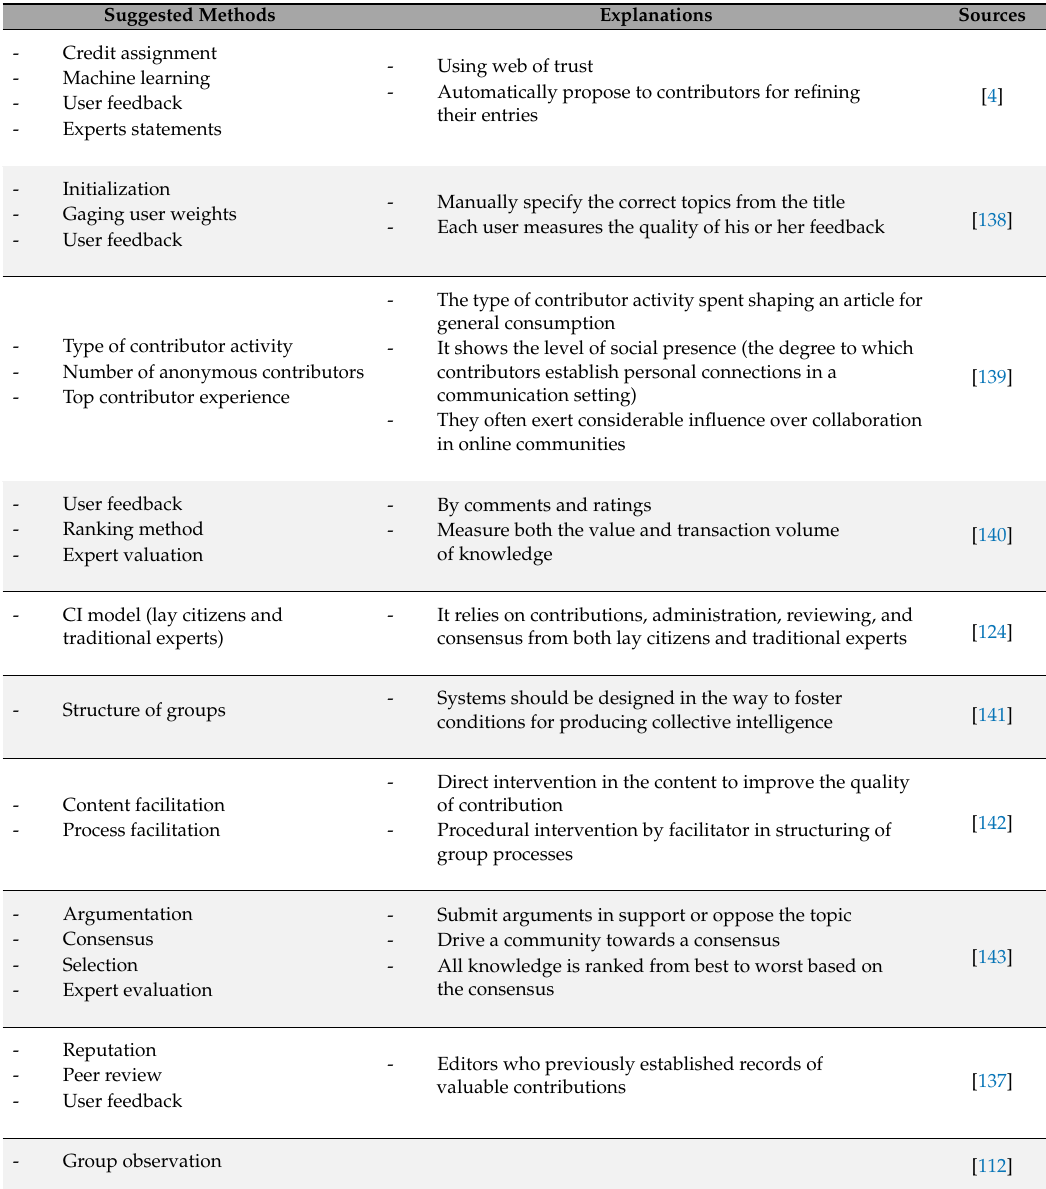
Table 14. Suggested methods in collected papers for evaluating the quality of